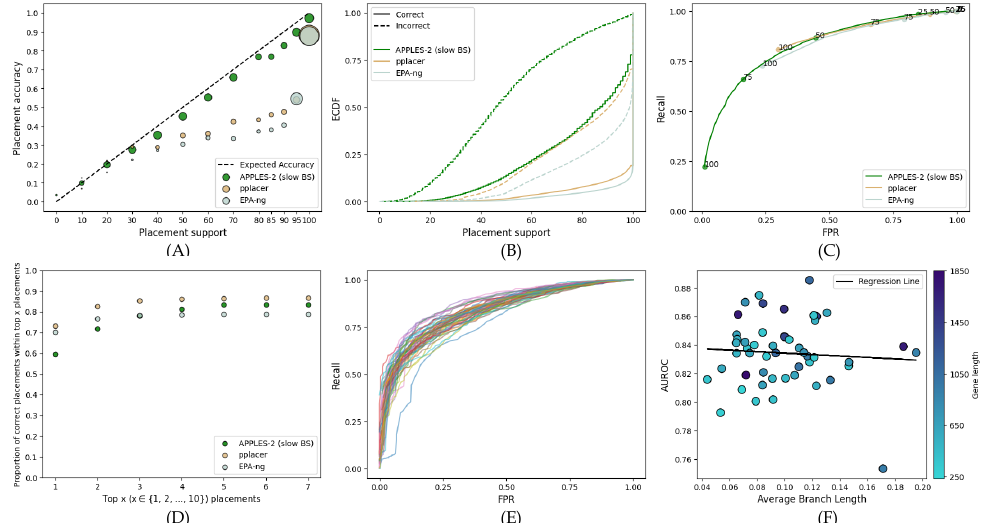
Figure 6. Results for the WOL AA dataset’s placement of each gene on its corresponding gene tree . In ( A – D ), we treat each gene as a replicate and show the combined results of the 50 genes. The settings for the subfigures ( A – D ) are similar to Figure 1.We also analyze each gene individually. ( E ) ROC curve for each gene shown separately. ( F ) AUROC for each gene versus the average branch length in the corresponding gene